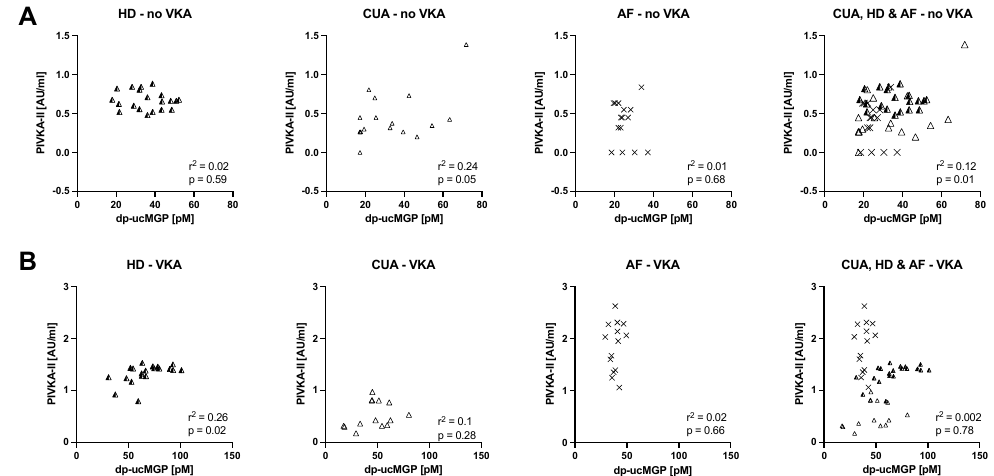
Figure 4. Weak correlations between PIVKA-II and dp-ucMGP of all patients of the CUA, HD and AF cohorts, separated into panel A ) without VKA treatment (r 2 ≤ 0.24) and panel B ) with VKA treatment (r 2 ≤ 0.26). Symbols in the right most graph correspond to the respective patient group.